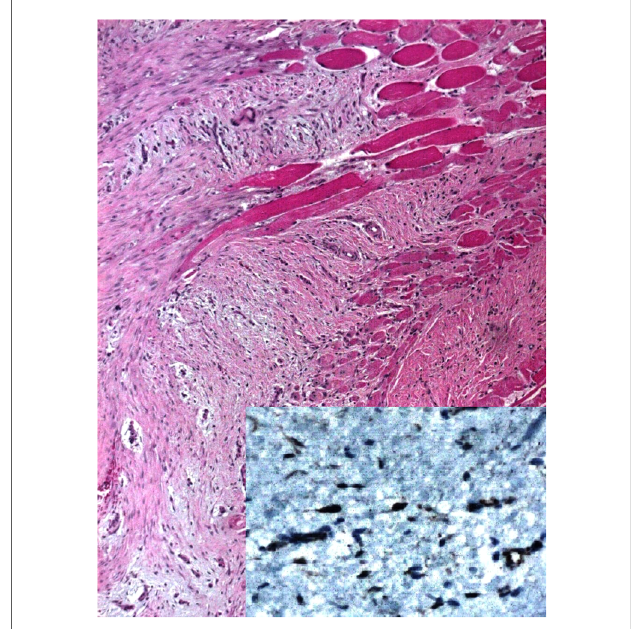
FIGURE 3 Pathology HE 4X, fusiform cells without nuclear hyperchromatism, hypocellular, and hyalinized areas are seen. Immunohistochemistry positive for Beta-catenin (Inset